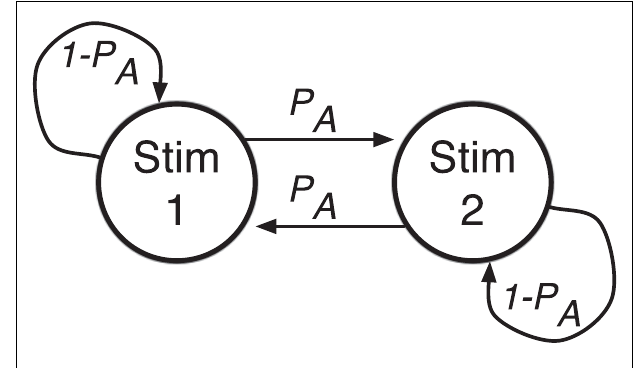
stimulus 2 (an alternation) with probability P A and stimulus 1 (a repetition) with probability 1 − P A